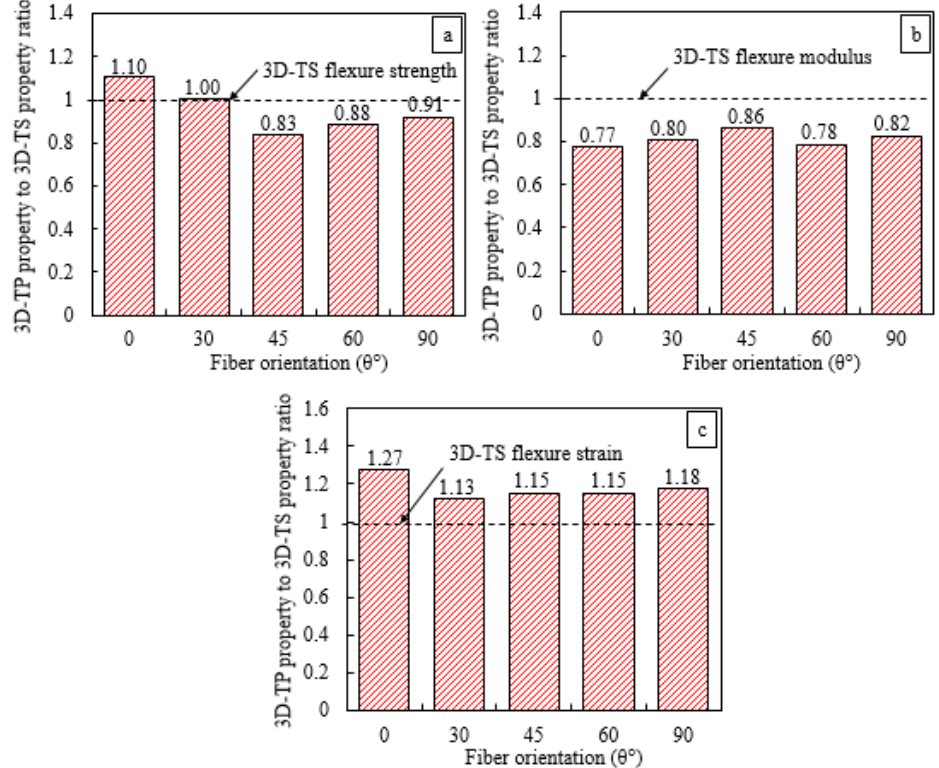
Figure 6. Comparison of normalised flexure strength, modulus and failure strain of 3D-FRC. ( a ) Flexural strength, ( b ) Flexural modulus and ( c ) Flexural strain.